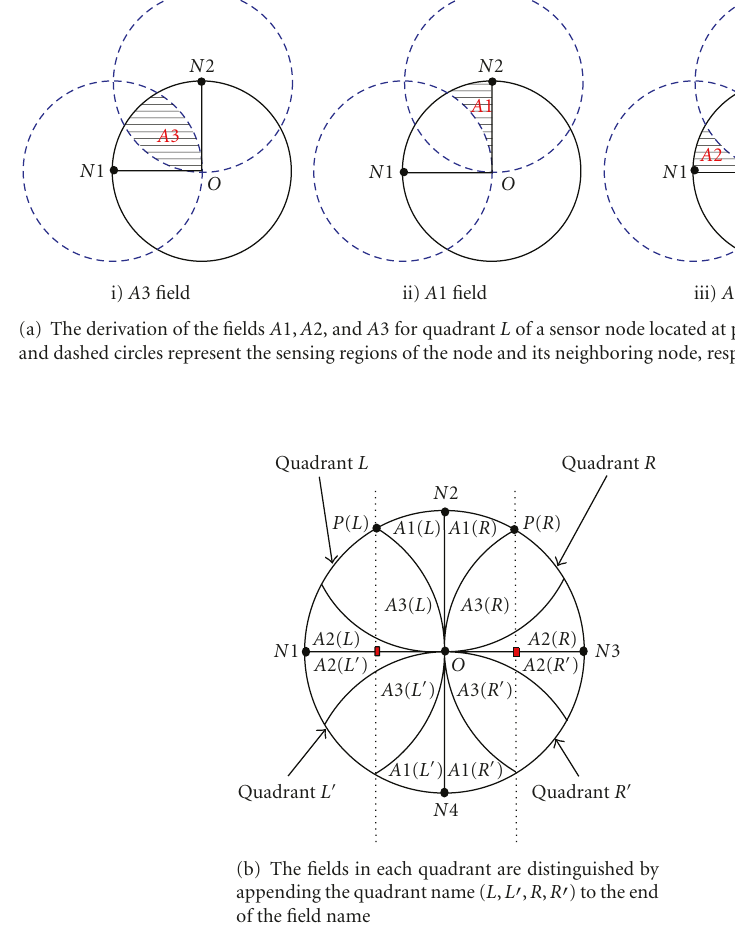
Figure 7: The division of a node’s sensing region into four quadrants to analyze its